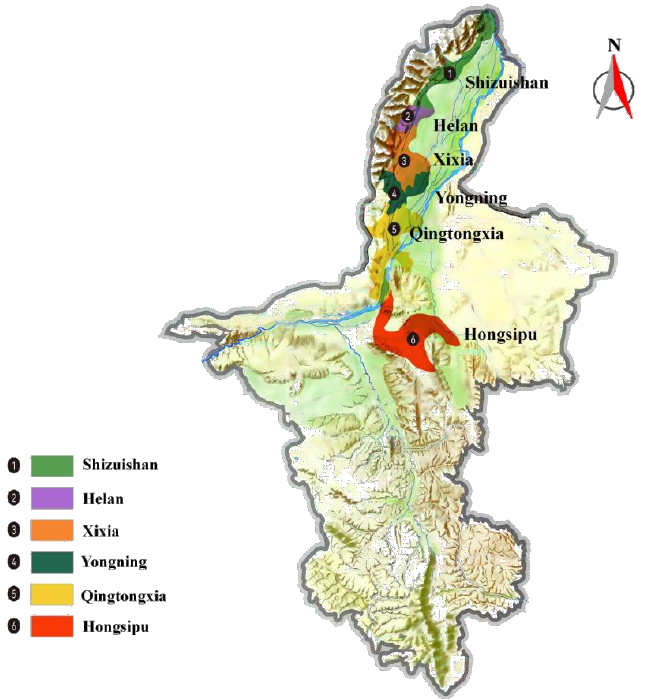
Figure 1. The topographic map of the six sub-regions from EFHM in Ningxia Hui Autonomous